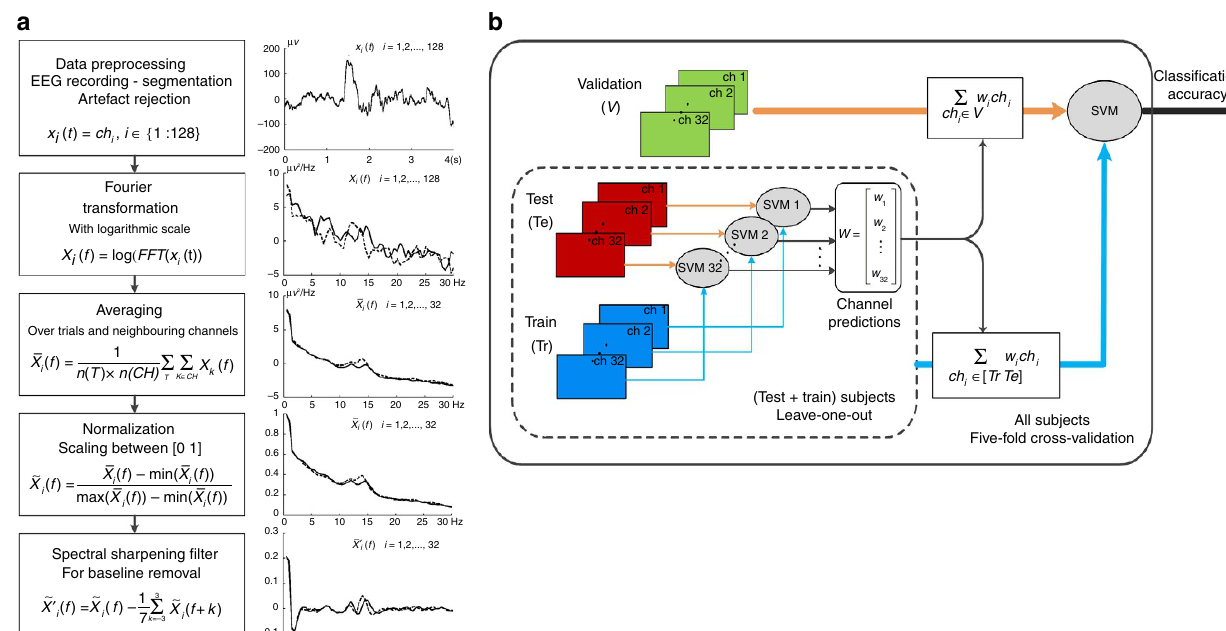
Figure 1 | Data preprocessing and MVPC analysis. ( a ) After artefact rejection, data from the remaining 4-s trials of 128-channel sleep EEG data was frequency transformed. To reduce the dimensionality of the data and to increase the signal-to-noise ratio, spectra were averaged over trials and neighbouring channels. Next, spectra of all channels were normalized separately to make them comparable, and a spectral sharpening filter was applied to remove the baseline spectrum and enhance differences between neighbouring frequency bins. ( b ) Training data were strictly separated from validation data in all MVPC analyses. Dimensionality of the data was further reduced in a two-step training procedure. Individual channel performance was determined using separate single-channel classifiers. An average of data from all channels weighted by their standalone performance was then used to train a classifier to distinguish between face and house stimulus conditions. Finally, classification was tested on independent validation